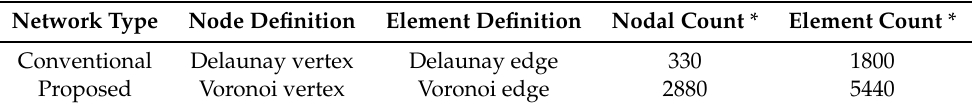
Table 2. Network feature counts.